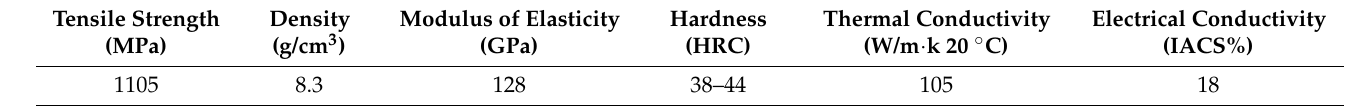
Table 2. Main mechanical physical properties of C17200 beryllium copper alloy [10].